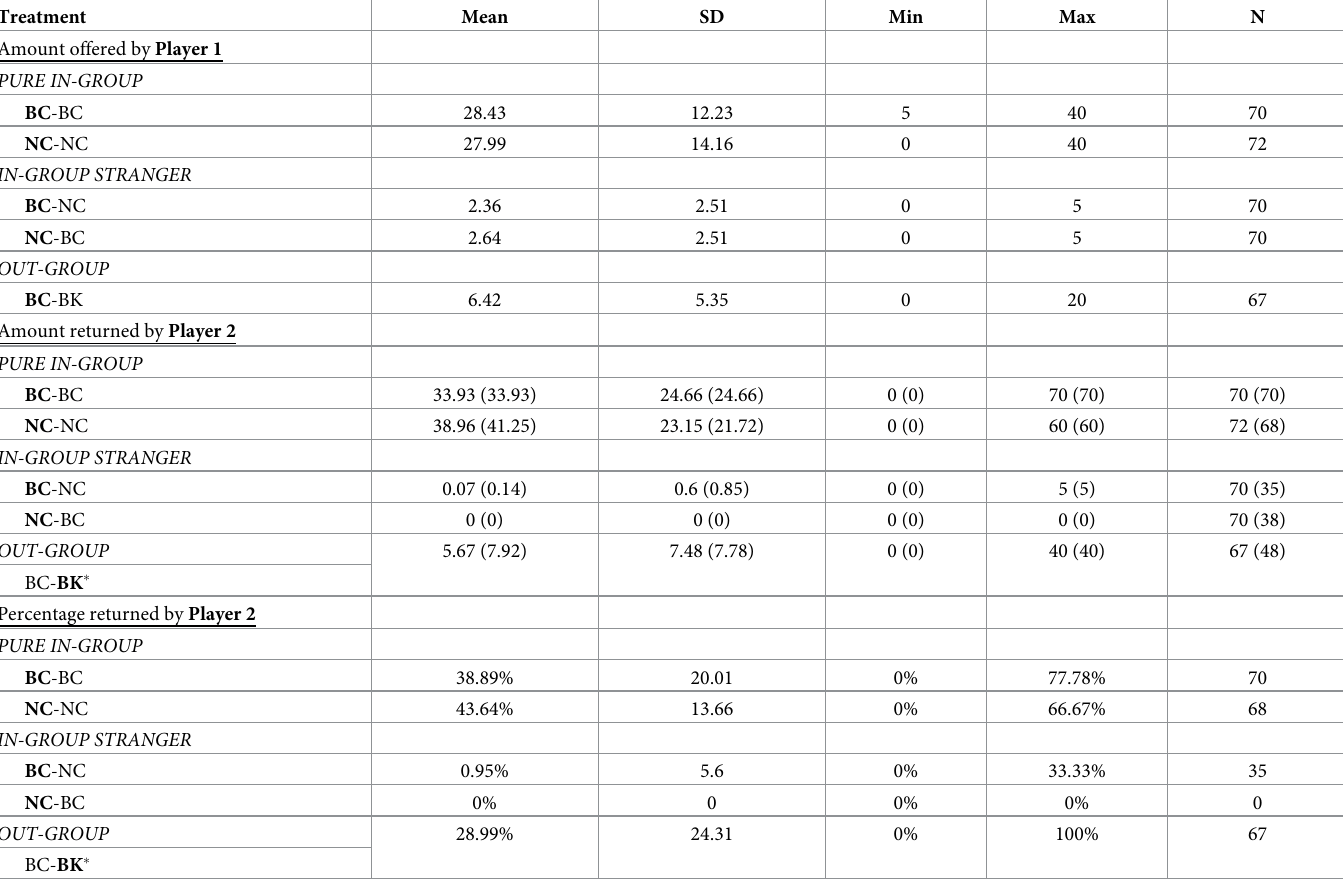
Table 3. Summary statistics of the amount sent and returned in Trust Game, by treatment and session. Treatment Mean SD Min Max